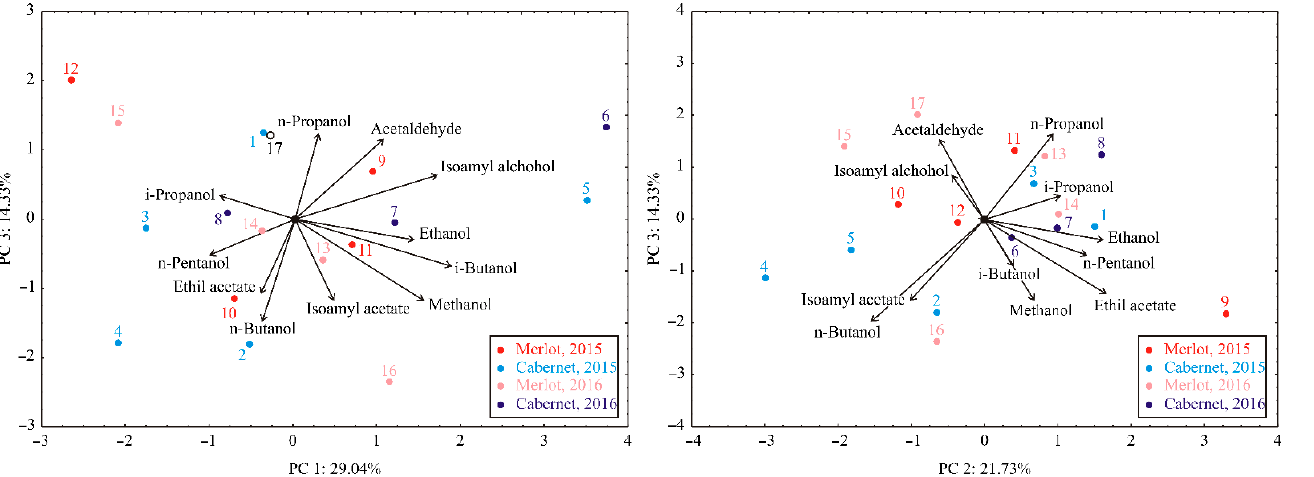
Figure 1. PCA ordination of variables based on component correlations. 4. Conclusions A method for the analysis of the volatile compounds (methanol, higher alcohols, es- ters and acetaldehyde) was developed and successfully validated. After a validation study, the following parameters were obtained: r 2 > 0.995; LOD = 0.2–1.0 mg/L; CV = 2.7– 6.3%, and recovery = 92–106%. The method was then applied for the analysis of Merlot and Cabernet Sauvignon wine samples vintaged in 2015 and 2016. Obtained results showed excellent suitability for these types of samples. The average content of the methanol in Merlot was 198.0 mg/L, while in Cabernet Sauvignon, it was 150.5 mg/L. Methanol content in Rose wine Merlot was only 65.9 mg/L. The average content of the higher alcohols was 398.5 mg/L, 335.8 mg/L, and 198.0 mg/L in Merlot, Cabernet Sauvignon, and Rose Merlot, respectively. Iso- amyl alcohol was the principal higher alcohol making up the 80% and 77% of the total amount of higher alcohols in Merlot and Cabernet Sauvignon, respectively. The percent- age of the n -propanol was the same, while in the case of isobutanol and n -butanol, it was approximately the same. The fraction of isopropanol, 2-butanol, and n -pentanol was be- low 1%. The content of the isoamyl acetate was below the limit of detection, while the average content of the ethyl acetate was 55.6 mg/L and 42.0 mg/L in Cabernet Sauvignon and Merlot, respectively. Acetaldehyde was also found in amounts of 16.1 mg/L and 23.3 mg/L in Cabernet Sauvignon and Merlot, respectively. Based on the results of the valida- tion process, this method was proved to be precise and accurate, and in combination with the simple preparation, i.e., incubation in headspace vial, is more suitable and simpler